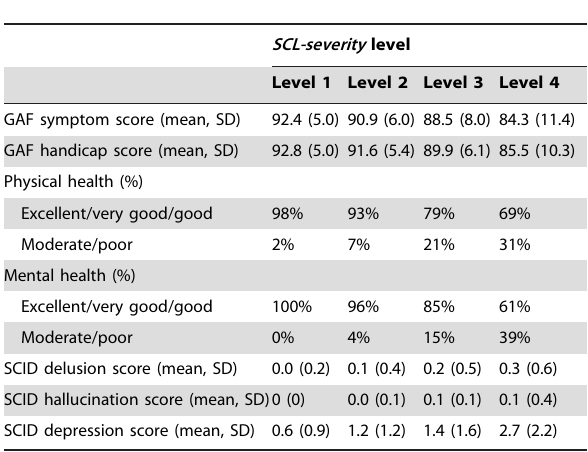
Table 1. Validation of the four quartile groups of the SCL-90 total score as representing increasing levels of symptom